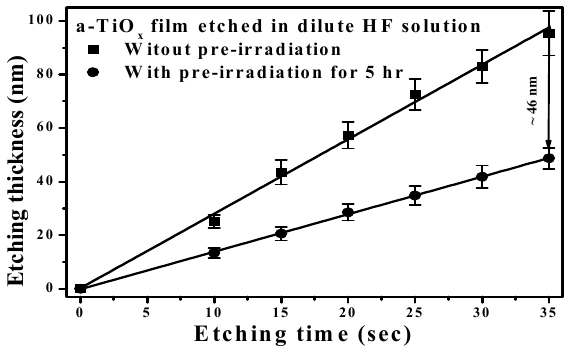
Figure 1. Etching thickness of the a-TiO x film with and without the UV light pre-irradiation and then immersed in the HF etching solution for different etching times.